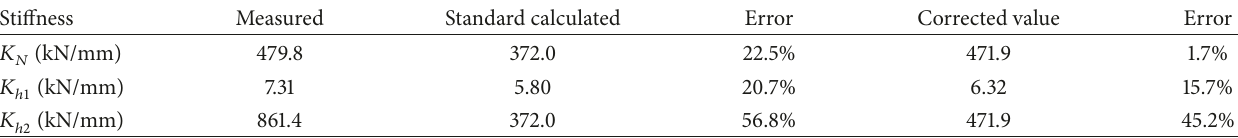
Table 3: Comparison among the theoretical stiffness and measured stiffness.